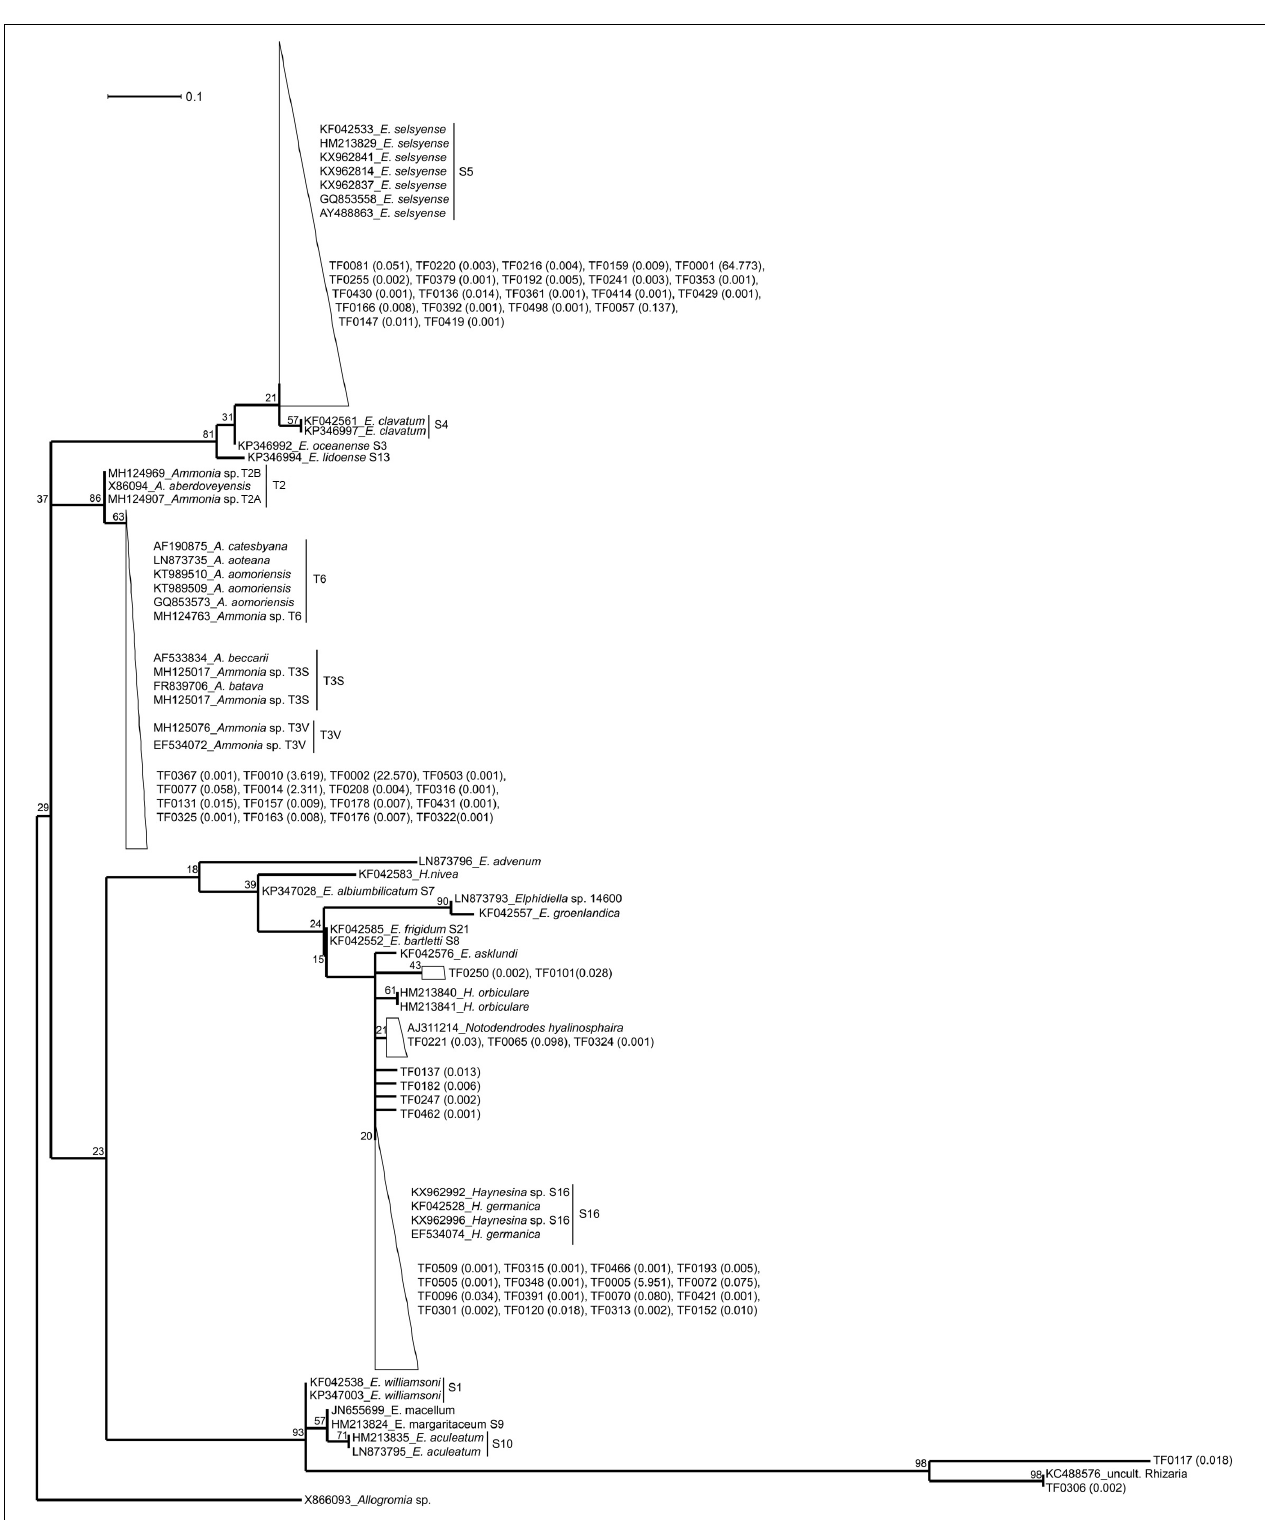
FIGURE 1 | Maximum likelihood phylogenetic tree of the foraminiferal OTUs and their closest relatives. The tree was built based on partial SSU rDNA sequences (about 117 bp) and inferred using the ML method with the Kimura 2-parameter model. Collapsed branches are indicated by a triangle/polygon. The tree was rooted on Allogromia sp. (X86093). Bootstrap support values over 1000 replicates are shown at the nodes. The number in parenthesis following the TF sequences indicates their % relative abundance over the total number of foraminiferal sequences. The bar represents 0.1 average nucleotide substitutions per site.